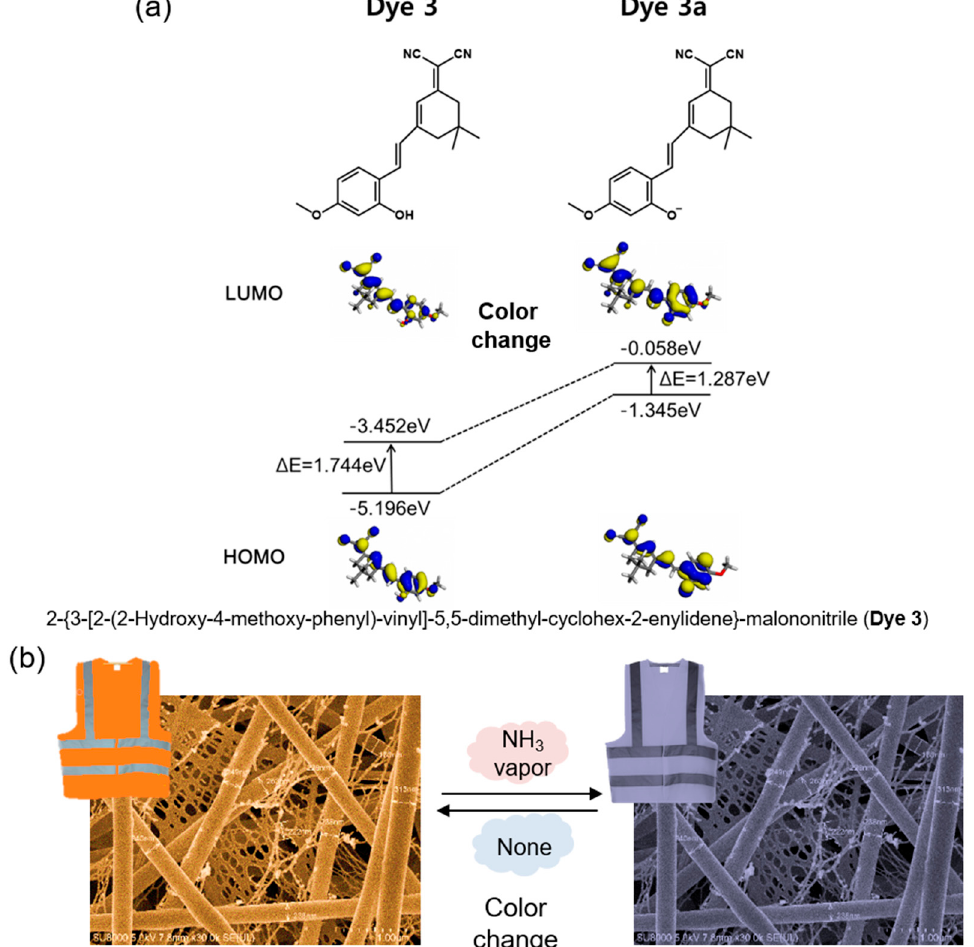
Figure 1. ( a ) Electron distribution of the HOMO and LUMO energy levels of dye 3 and dye 3a [32] and ( b ) a scheme depicting the color change of the colorimetric nanofiber sensor when exposed to NH 3 gas.